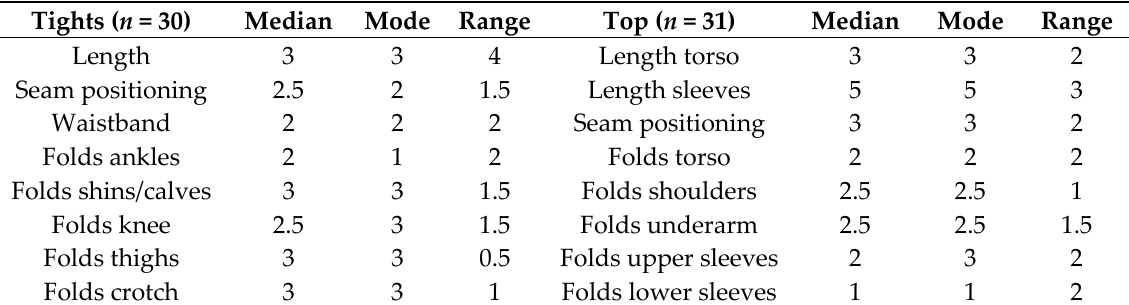
Table 2. Results of fit assessment (mean of front and